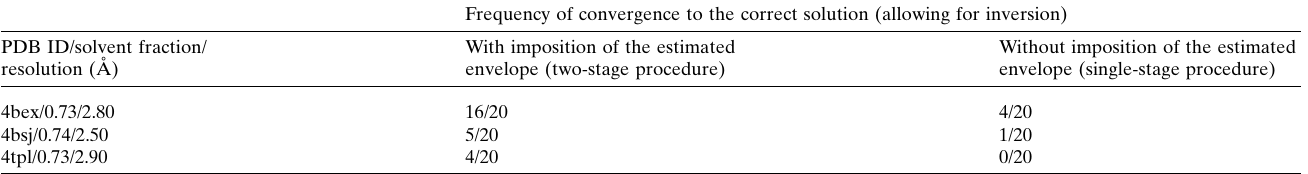
Table 3 The effect of initial imposition of the molecular envelope of the efficiency of the phase determination step. PDB ID/solvent fraction/ resolution (A˚ )